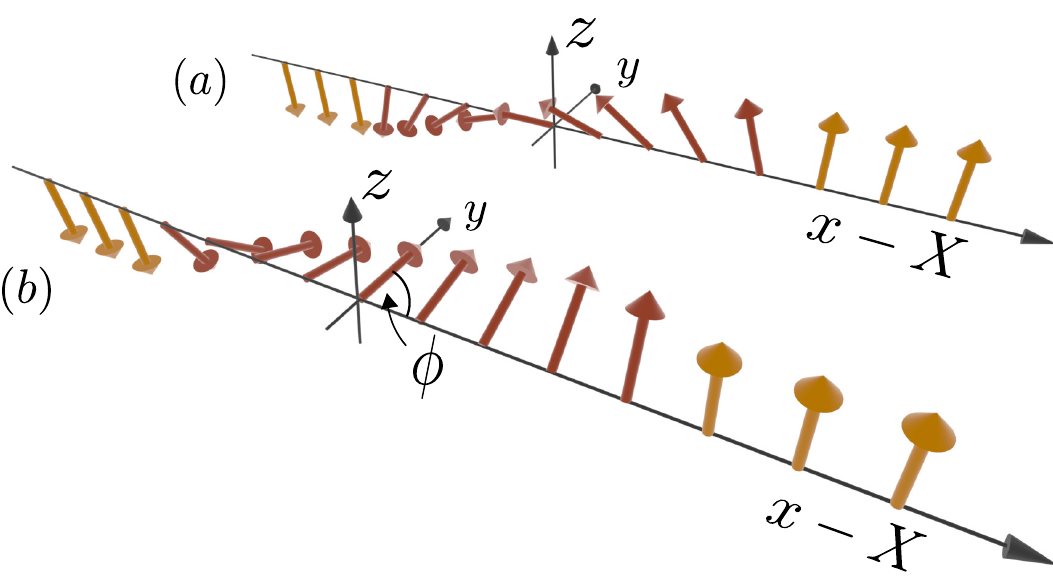
Figure 1: Examples of domain wall configurations with the domain wall plane in the yz -plane. Here ( a ) is a Néel wall with internal angle φ = π , and ( b ) is a Bloch wall with internal angle φ = π/